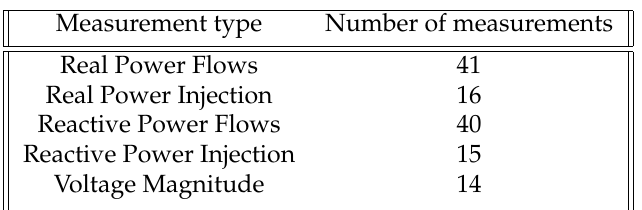
Table 4. IEEE 30 Bus - Meter distribution